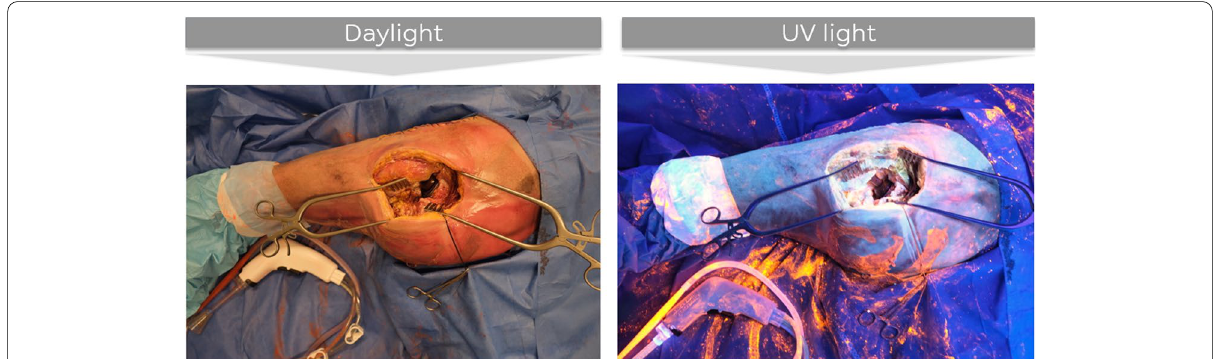
Fig. 1 The appearance of orange fluorescent powder (GloGerm, Hygienic Solutions, Lincoln, UK) under normal daylight and under UV light. No additional measures protocol (bacterial load of 3 2,5 mg GloGerm ×